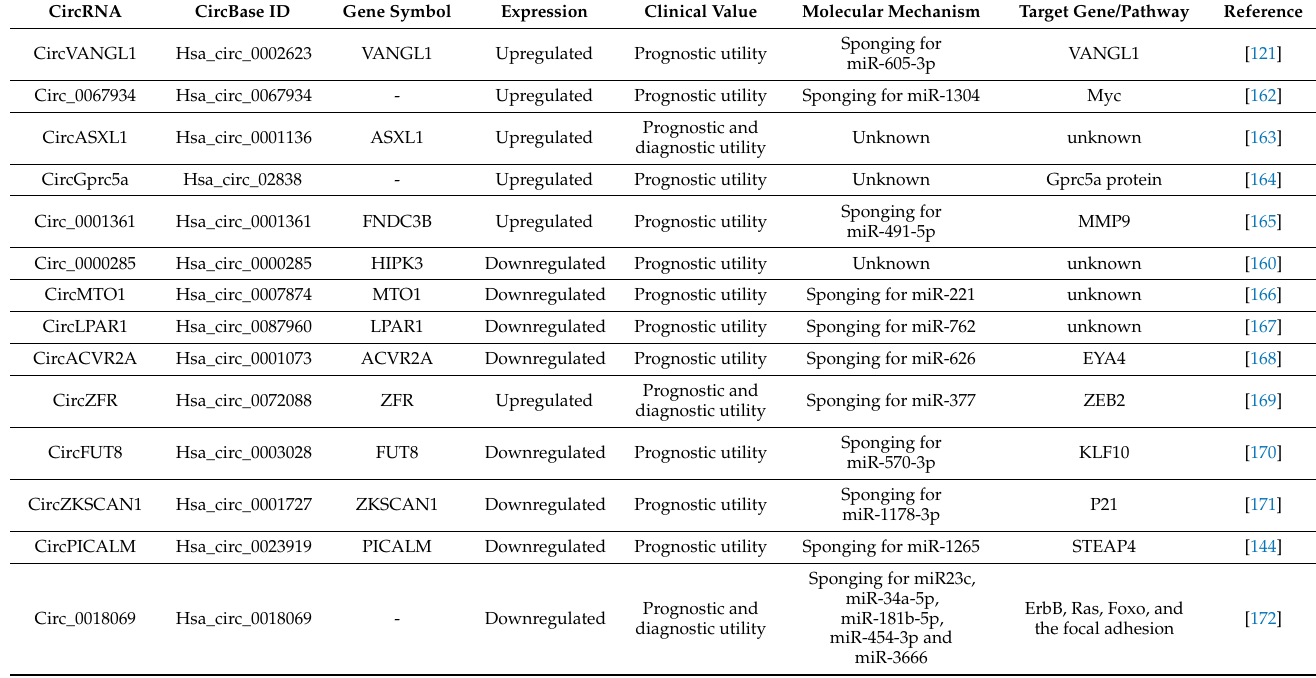
Table 3. CircRNAs and their values in bladder cancer diagnosis and prognosis.